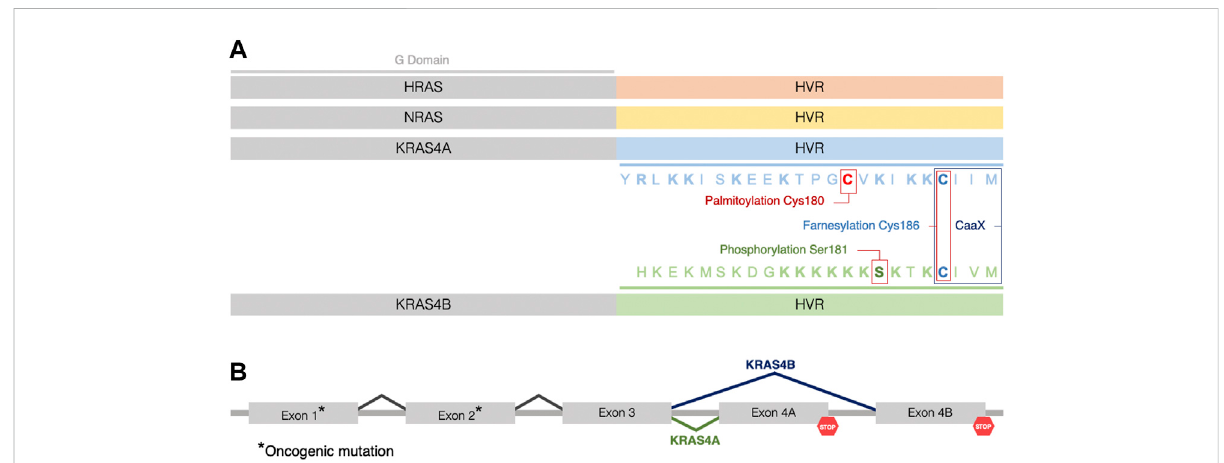
FIGURE 1 Three RAS genes encode four RAS proteins. (A) The four RAS isoforms have nearly identical GTP/GDP binding (G) domains (grey) (aa1 – 165) but distinct hypervariable (HVR) regions (aa166 – 188/189, not to scale), which direct membrane traf fi cking. Color coding of the HVR distinguishes each RAS isoform (HRAS in orange, NRAS in yellow, KRAS4A in blue, and KRAS4B in green). Sequence and posttranslational modi fi cations of the HVR of KRAS4AandKRAS4Bareindicatedbycolorshighlightingtheresiduesthatarepalmitoylated(red),phosphorylated(green)orfarnesylated(blue). Basic residues in the HVRs of KRAS4A and KRAS4B are indicated in bold. (B) The two KRAS isoforms are splice variants utilizing alternative 4th exons. Oncogenic mutations occur in exons 1 or 2 (*) such that when KRAS is mutant, both splice variants give rise to oncogenic